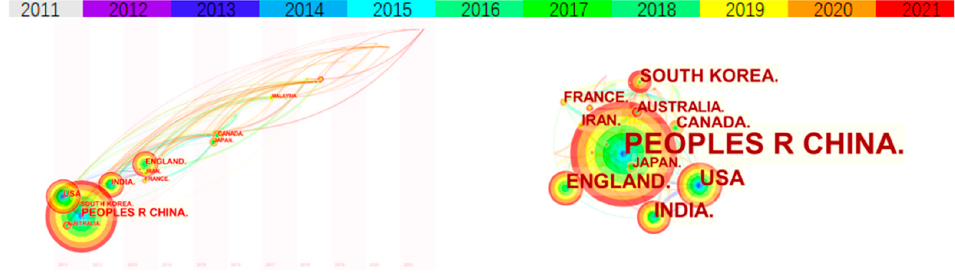
Figure 2. Visualization network map of the country co-authorship analysis.